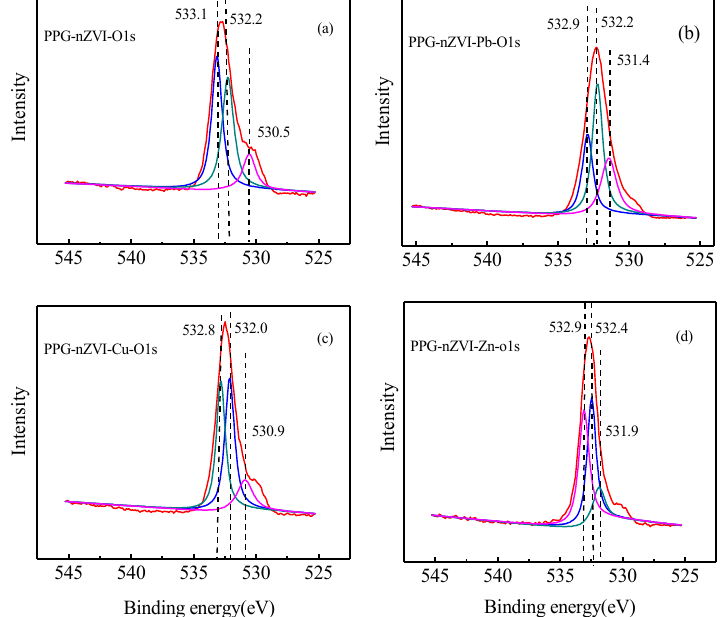
Figure 7. XPS spectroscopy of O 1 s for fresh PPG-nZVI beads ( a ) and for PPG-nZVI beads reaction with Pb 2+ ( b ), Cu 2+ ( c ), and Zn 2+ ( d ).